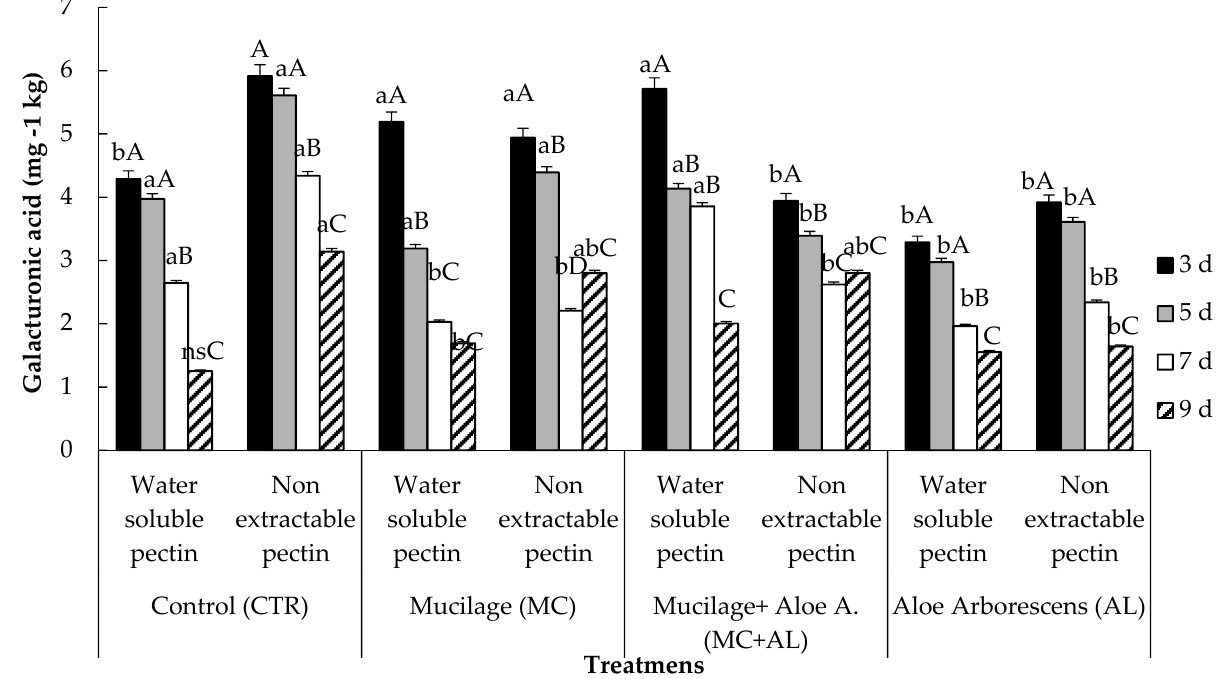
Figure 5. Water soluble pectin (WSP) and non-extractable pectin (NXP) of fruit slices of Actinidia deliciosa (Liang, Ferguson) coated with O. ficus-indica (OFI) mucilage + glycerol (MC), or OFI mucilage (MC), or mucilage + A. arborescens (MC+AL), or A. arborescens (AL) not treated (CTR), just after being coated (0) and at 3, 5, 7, 12 days of storage at 5 °C. Different lowercase letters indicate significant differences between treatments at each sampling date. Different capital letters indicate significant differences between sampling date for the same treatment. Tukeys’ significant test was applied at p ≤ 0.05. Data are means ± S.E. (n = 3).